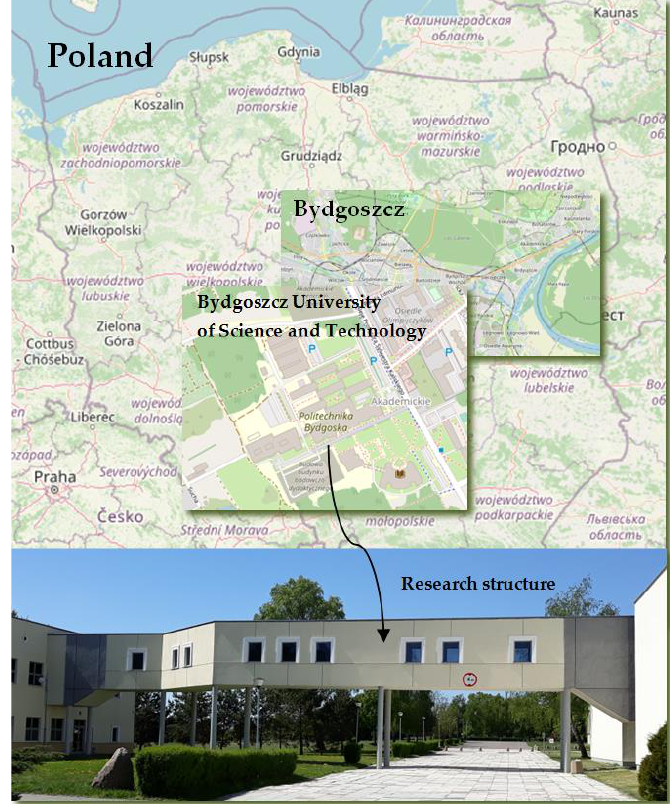
Figure 1. Location of the research structure [own elaboration].